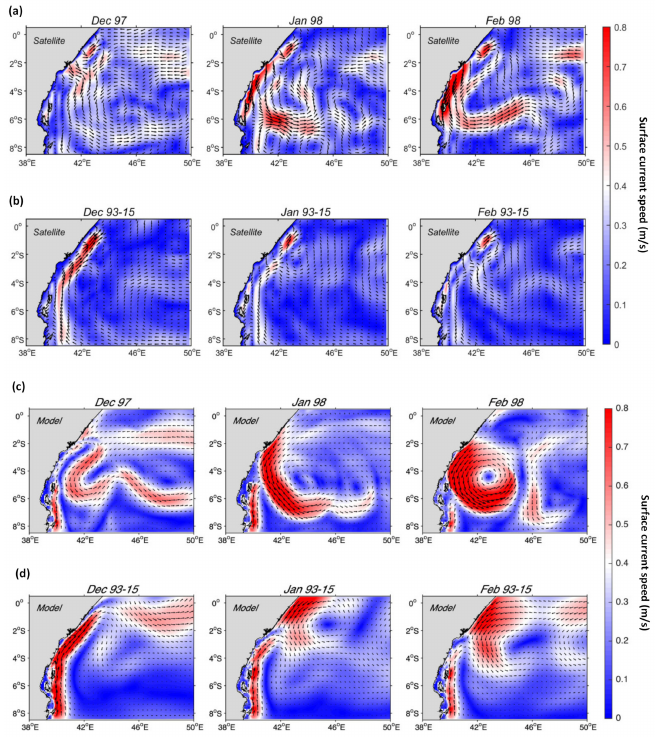
Figure 2. Surface circulation o ff the East African coast during the 1997–98 El-Niños and Positive Indian Ocean Dipole (IOD + ), relatively to the climatology (1993–2015). Surface currents (m / s) between December 1997 to February 1998 from ( a ) satellite data and ( c ) the model are presented relative to their ( b , d ) climatological